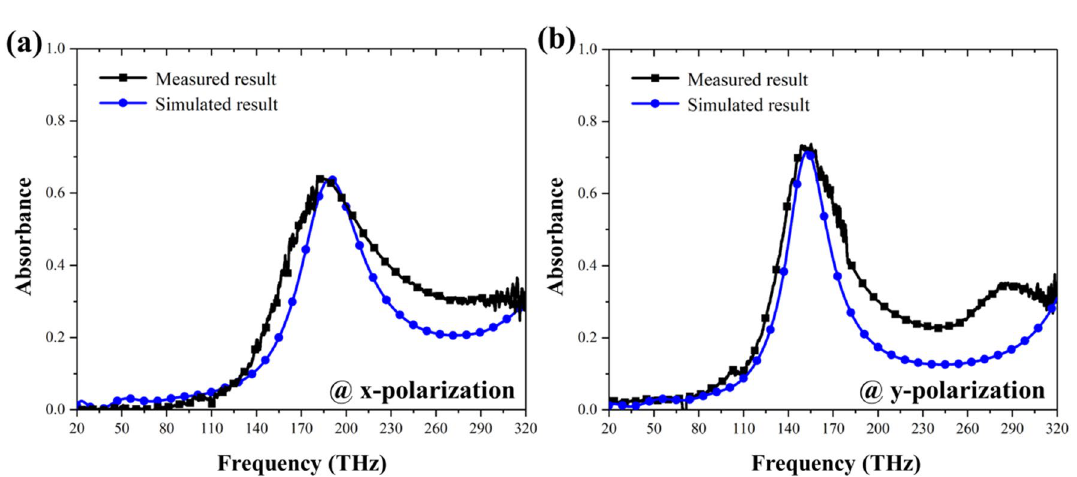
Figure 7. Measured absorbance of the planar MPA at ( a ) x- and ( b ) y-polarization. Measured absorbance agrees with the simulated ones well, establishing the correctness of material properties in